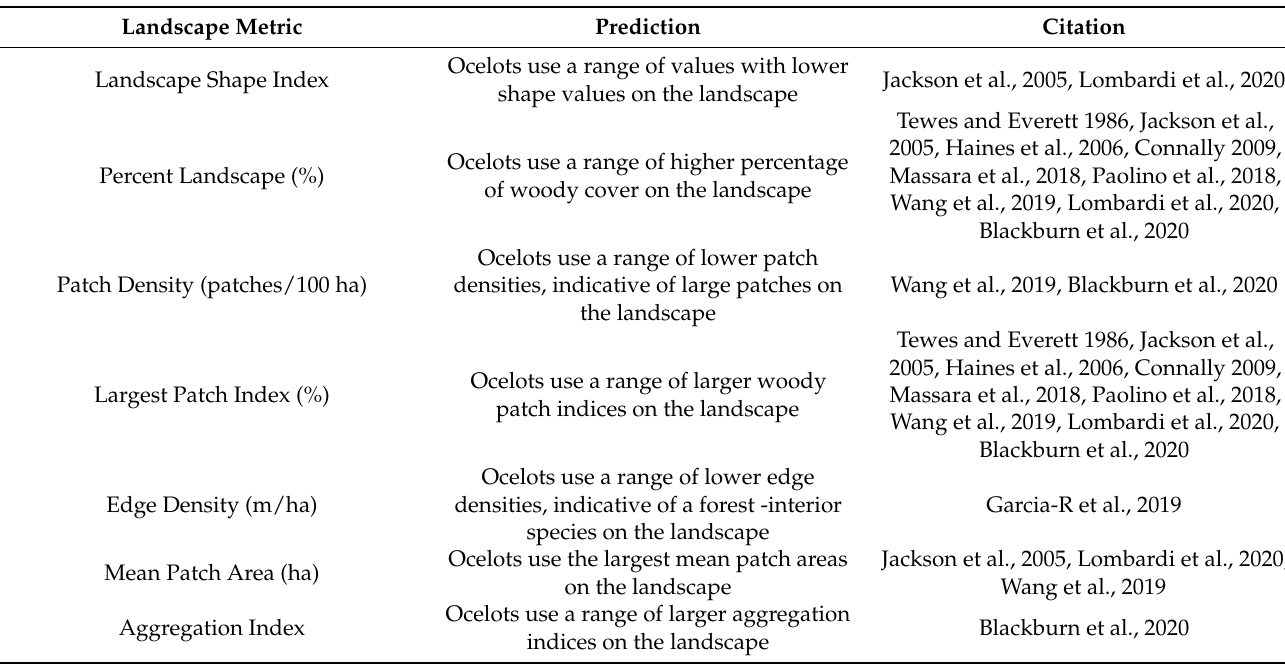
Table 1. A priori predictions and justification for landscape metrics of woody cover for inclusion in gradient + slack landscape suitability model for ocelots ( Leopardus pardalis ) in southern